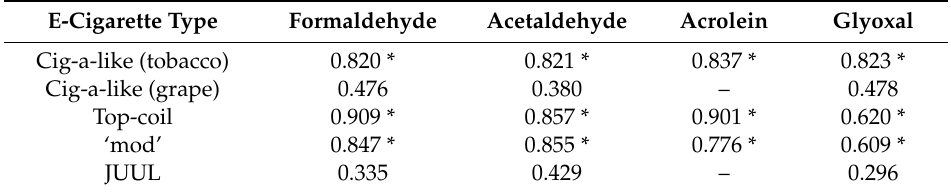
Table 2. Correlation coe ffi cients of CO and carbonyl compounds in e-cigarette aerosols. Asterisk marks (*) indicate Pearson’s correlation coe ffi cients with statistical significance ( p <